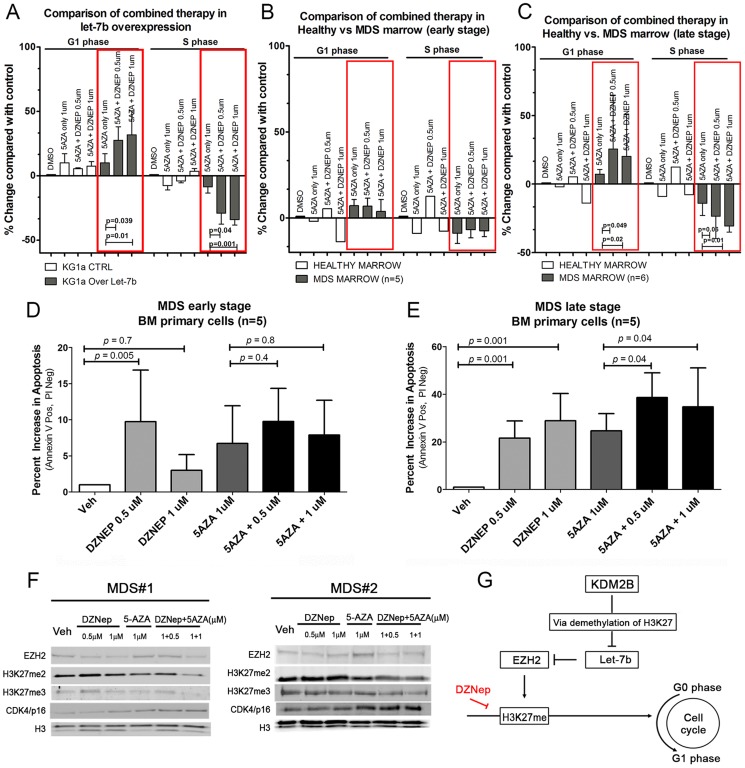
Response of cell lines and primary marrow cells to DZNep and 5AZA.Proliferation study in, A) KG1a cells overexpressing let-7b, B) primary marrow cells from healthy donors and MDS patients with <10% marrow blasts, and C) MDS patients with 10%–20% marrow myeloblasts. Exposure to DZNep, 5AZA or both affected the proliferation in KG1a cells overexpressing let-7b and cells from MDS marrows with 10%–20% but not in cells from patients with <10% marrow blasts (or healthy donors). Exposure to DZNep, 5AZA or combination of both agents (inside of red boxes) affected the proliferation in KG1a cells overexpressing let-7b and cells from MDS marrows with 10–20% but not in cells from patients with <10% marrow blasts or healthy donors. D) and E) show the extent of apoptosis induced by DZNep, 5AZA or both in MDS patients with <10% and 10%–20% marrow blasts, respectively. The extent of apoptosis was significantly greater in MDS marrows with higher myeloblast counts, more so in cells being treated with the drug combination than with single agents (p = 0.04, 0.001). The results are displayed as mean ±SEM for each MDS group (5 samples for <10% marrow blasts and 6 samples for 10–20% marrow blasts) (Student t-test). F) Two different primary BM CD34+ cells specimens showing decreased H3K27m2 and H3K27m3, and decreased EZH2 protein expression upon combined treatment with Dznep+5AZA; Histone H3 served as nuclear loading control. G) Working model: role of KDM2B/let-7b/EZH2 in epigenetic regulation of cell proliferation in MDS. KDM2B represses let-7b and up-regulates EZH2. DZnep treatment inhibits histone: H3K27; methylation and bypasses the KDM2B/let-7b/EZH2 effect leading to reduced cell proliferation.